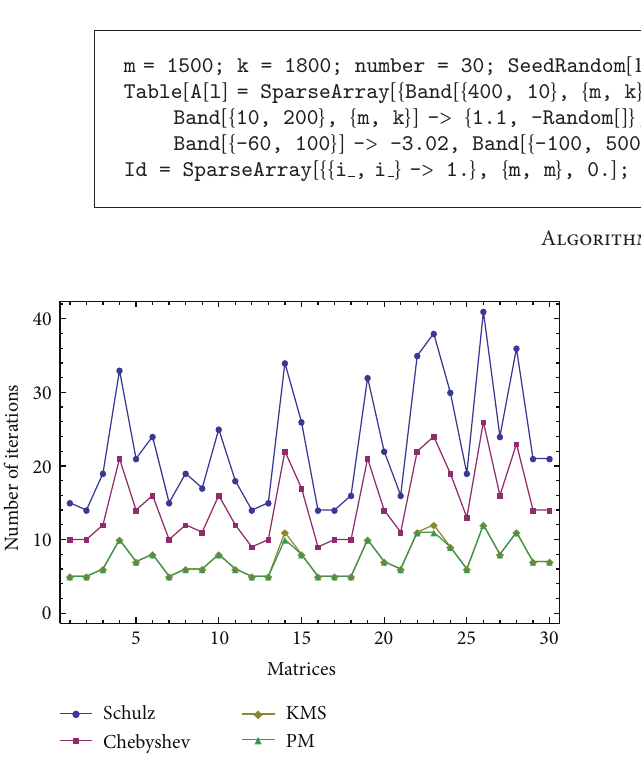
Figure 2: The results of comparisons for Experiment 1 in terms of the elapsed time using ‖𝑉 𝑛+1 − 𝑉 𝑛 ‖ ∞ ≤ 10 −6